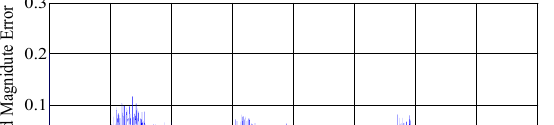
Fig. 1 General Base-band Measurement Setup [9]